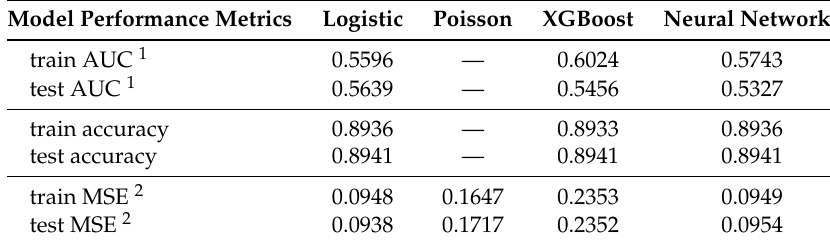
Table 6. Performance metrics for the four predictive models.